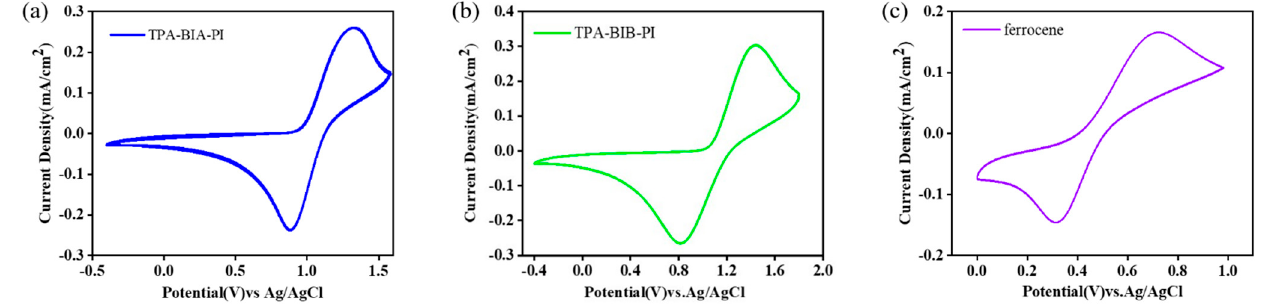
Figure 8. Cyclic voltametric diagrams of the polymers ( a ) TPA-BIA-PI, ( b ) TPA-BIB-PI, ( c ) ferrocene in CH 3 CN containing 0.1M TBAP at a scan rate of 100 mV · s − 1 .